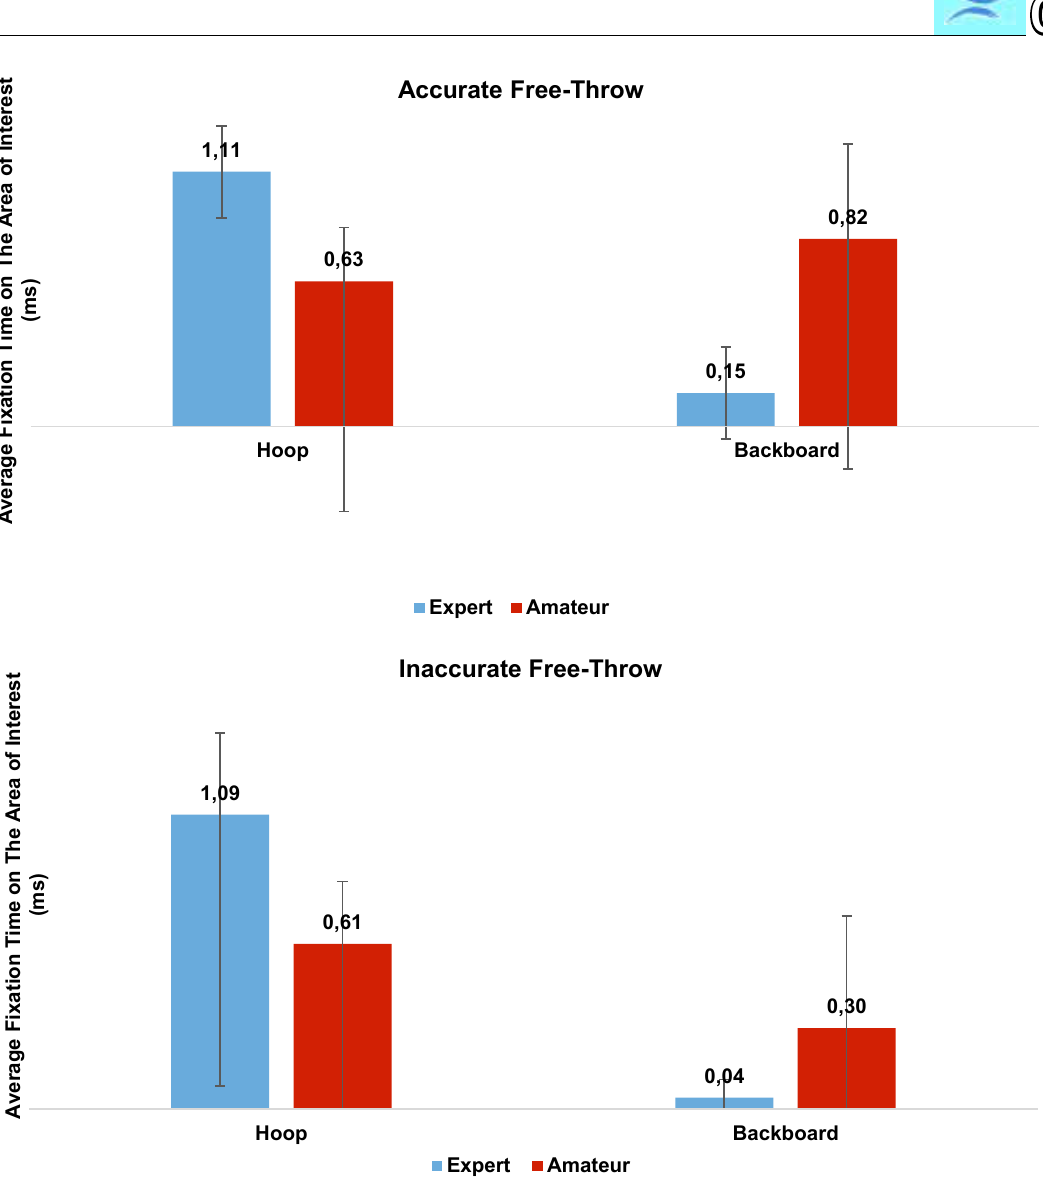
Fig. 6. The average fixation duration on the areas of interest during accurate and inaccurate free